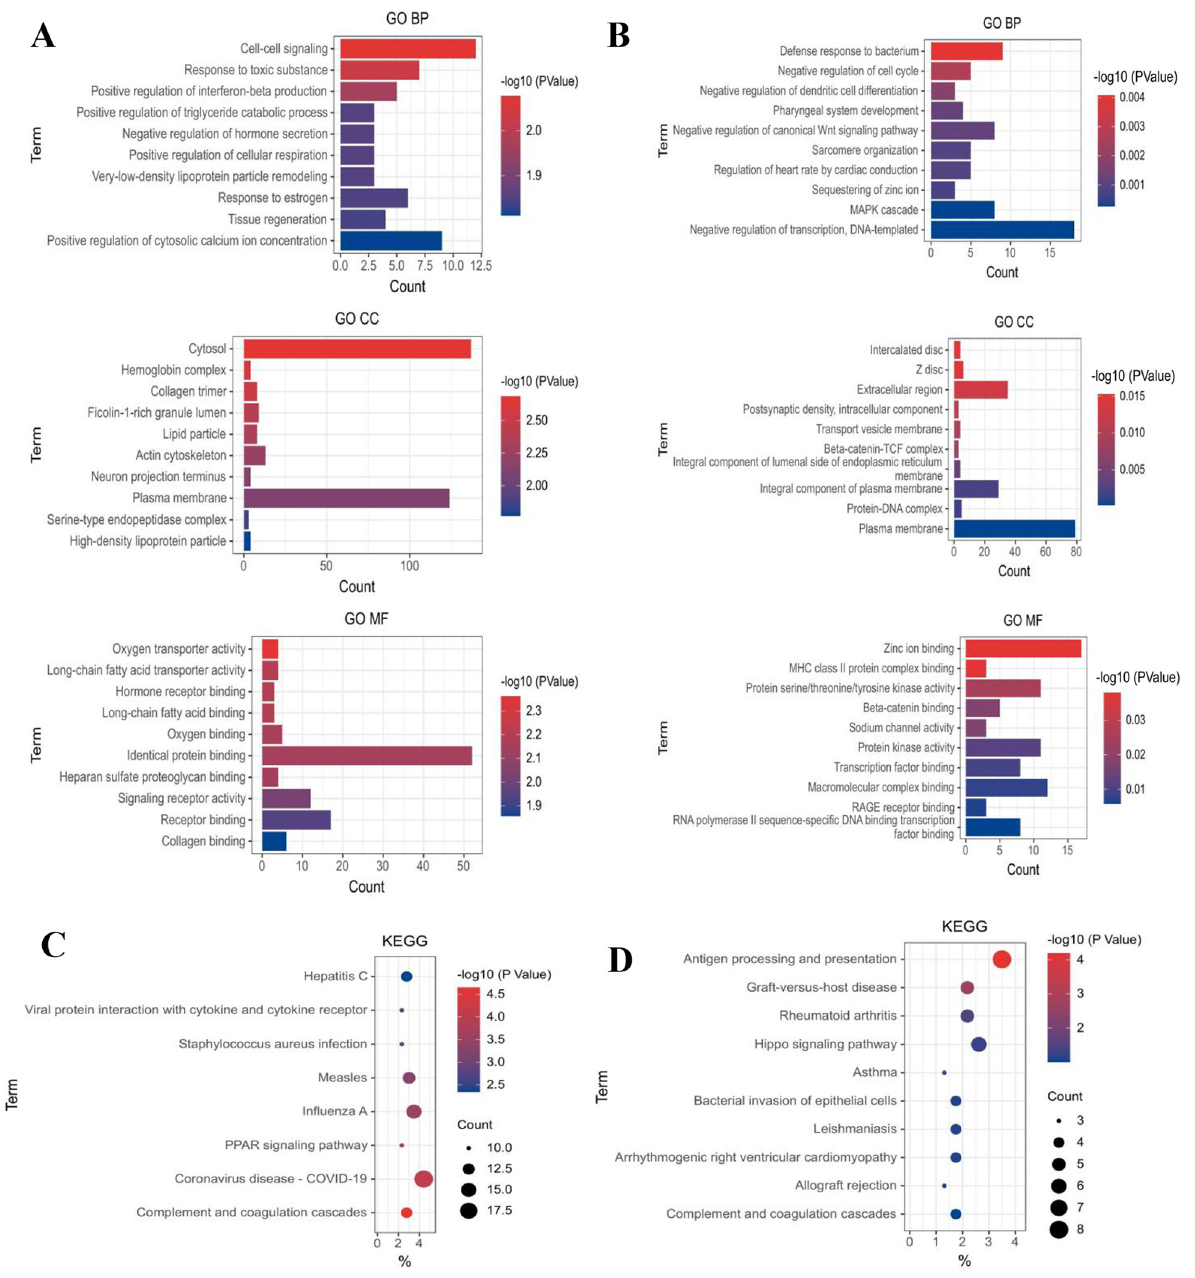
Fig 2. Functional prediction of differentially expressed mRNAs in PAH. (A)GO and (C) KEGG pathway analysis of upregulated mRNAs in PAH. (B) GO and (D) KEGG pathway analysis of downregulated mRNAs in PAH. GO, gene ontology; KEGG, Kyoto Encyclopedia of Genes and